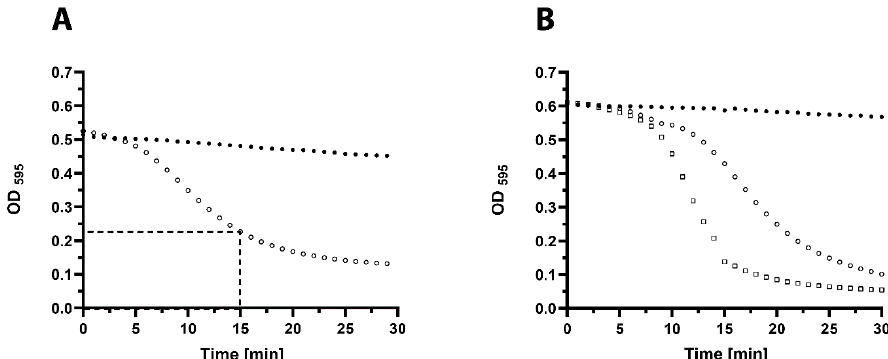
Figure 4. Turbidity reduction assays to determine 1 Unit (1U) of 23TH_48. Mid exponential cells were washed with phosphate buffered saline (PBS) and exposed to different concentrations of 23TH_48 at 37 °C to find the concentration that in 15 min halves the optical density (OD) at 595 nm. ( A ) S. pneumoniae R6 cells alone (filled circles), and in the presence of 1U of 23TH_48 which was found to be 64 ng/µL (open circles). ( B ) S. pneumoniae DSM 24048 cells (serotype 19F) alone (filled circles), and in the presence of 1U of 23TH_48 which was found to be between 1 ng/µL (open circles) and 1.5 ng/µL (open squares).